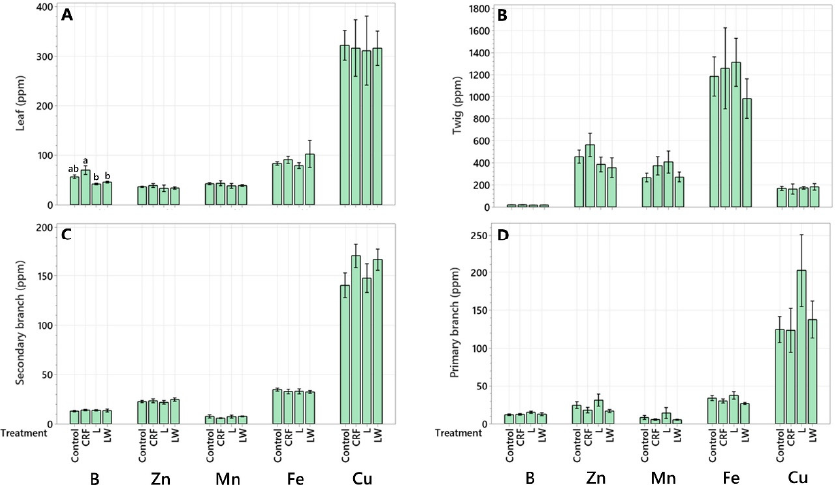
Figure 3. Micronutrient concentration (ppm) in leaf ( A ), twig ( B ), secondary branch ( C ), and primary branch ( D ). Six-year-old Huanglongbing-affected ‘Ruby Red’ grapefruit trees grafted on sour orange rootstock were used. Treatments consisted of two liquid (L and LW) and two granular fertilizers (Control and controlled-release fertilizer (CRF)). Treatments were applied three times a year (control and CRF), biweekly (L), or weekly (LW), for three years. A one-way variance (ANOVA) with a Tukey’s honestly significant difference (HSD) test was used to determine significant differences between means. Lowercase letters (a, b) indicate statistically significant differences ( p ≤ 0.05). Data represents means ( n = 4) ± standard error.